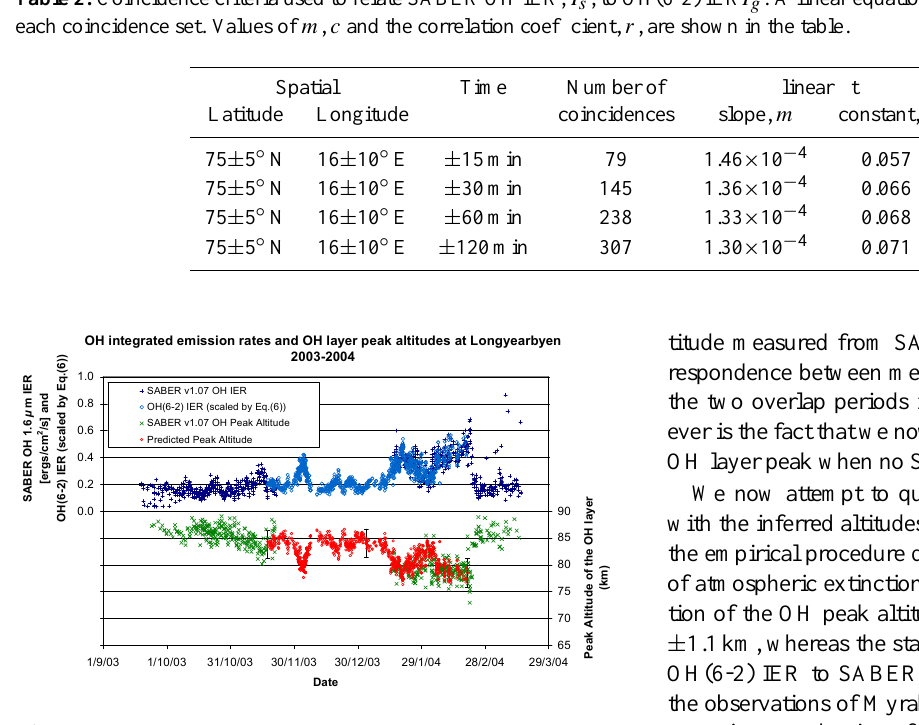
Fig. 7. OH layer peak height measured by SABER at Longyear- byen (78 ± 5 ◦ N, 16 ± 10 ◦ E) (green) and OH layer peak height pre- dicted by empirical formula for all OH(6-2) data (red) (including the period when SABER was looking south) during the 2003–2004 season. The error bar shown in black indicates the uncertainty ( ± 2.7km) in the peak altitudes determined. SABER OH IER and OH(6-2) IER values (blue) are also shown in this plot to illustrate the inverse relationship between OH brightness and peak